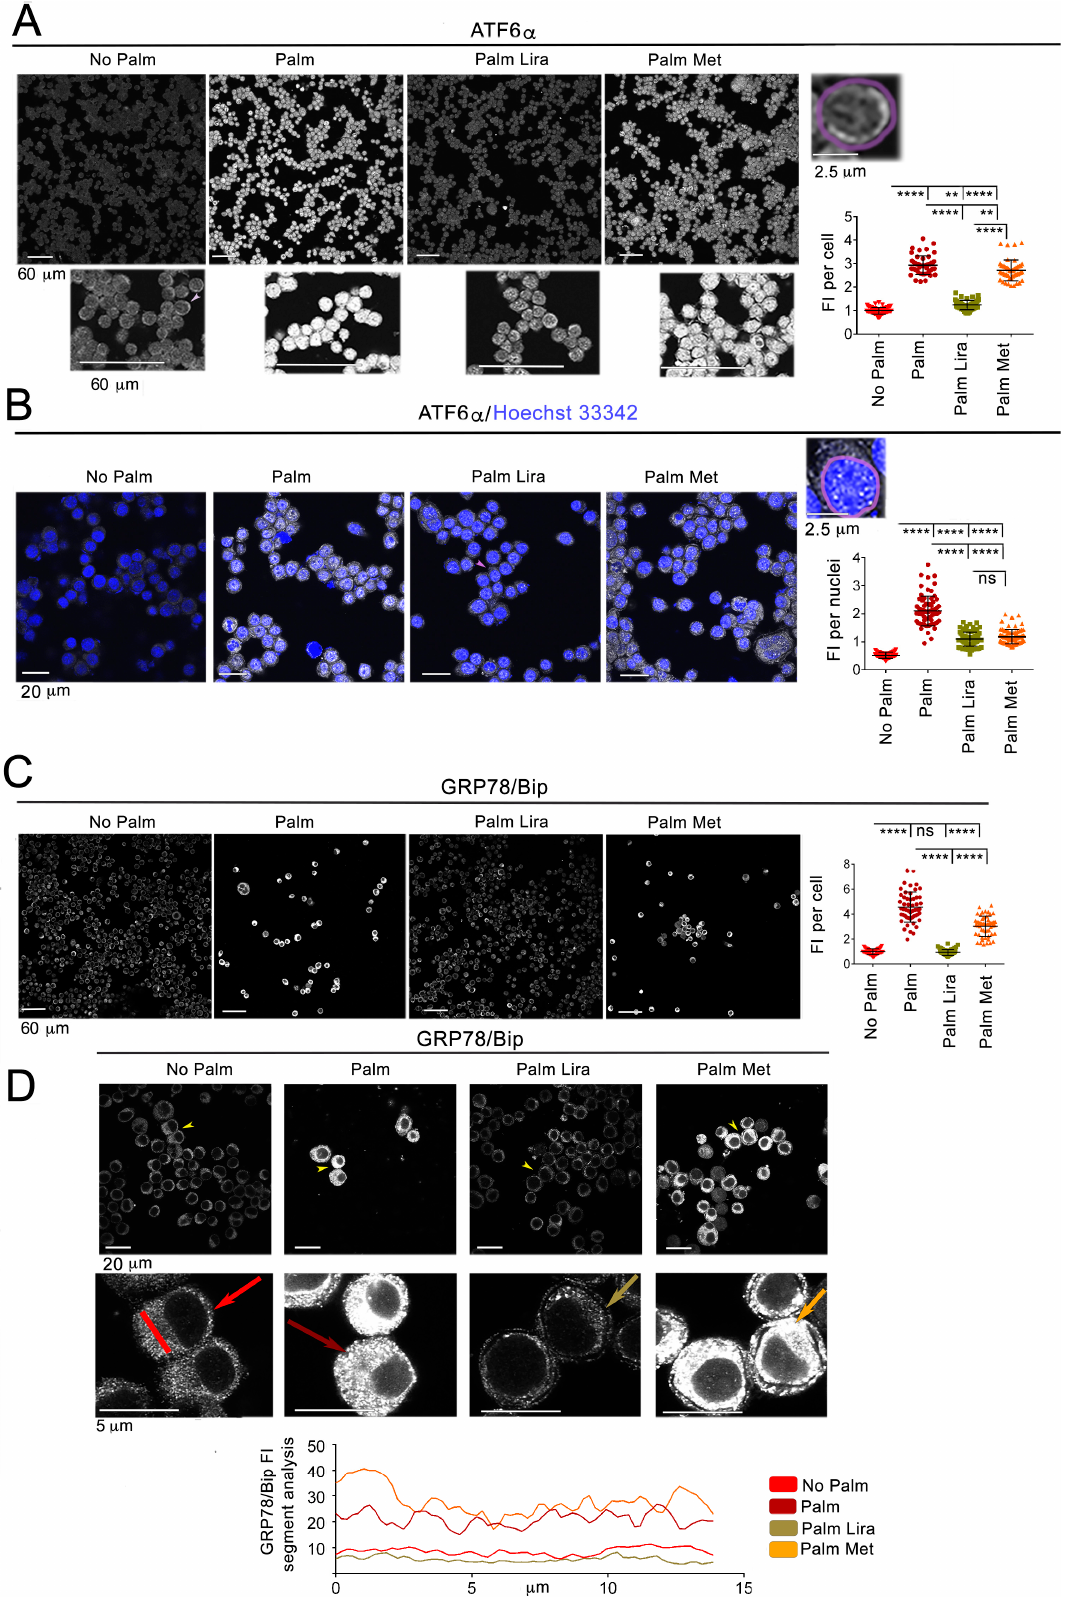
Figure 1. Liraglutide prevents changes in ER proteostasis and ER morphology caused by palmitate in Neuro2A cells. Metformin is less effective in counteracting ER stress. ( A ) Neuro2A cells